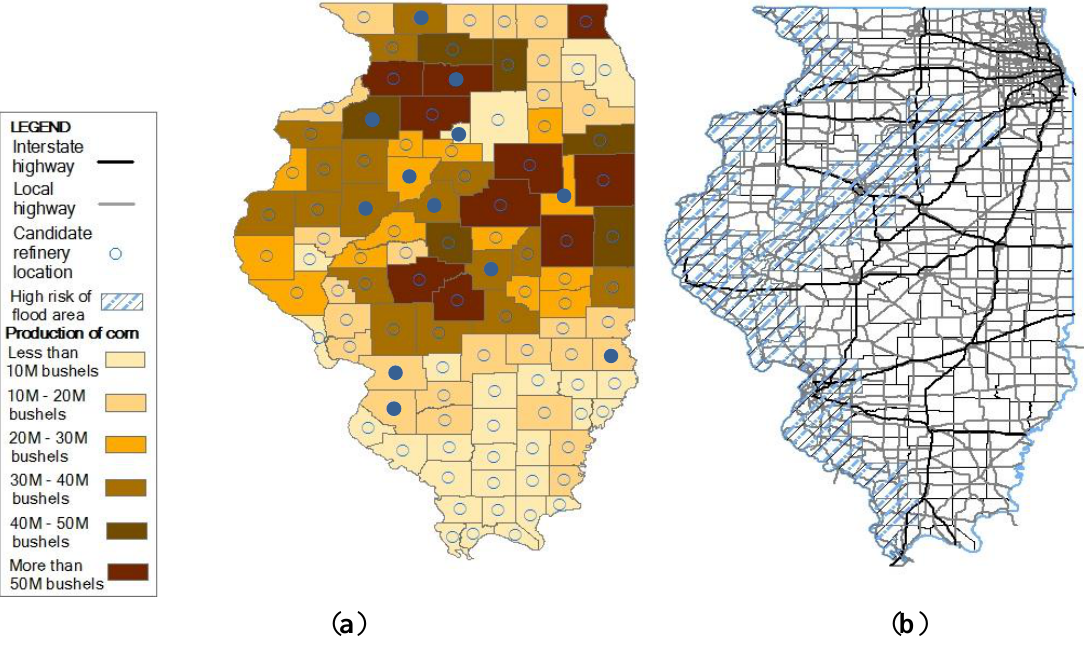
Figure 1. Maps for the Illinois case study. ( a ) Projected corn production projection levels, existing and candidate refinery locations in year 2022; ( b ) Highway network and flood-prone